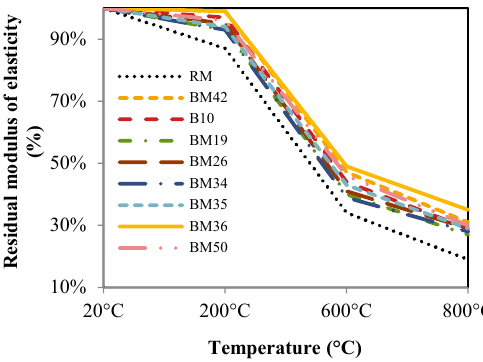
Figure 14. Residual modulus of elasticity.